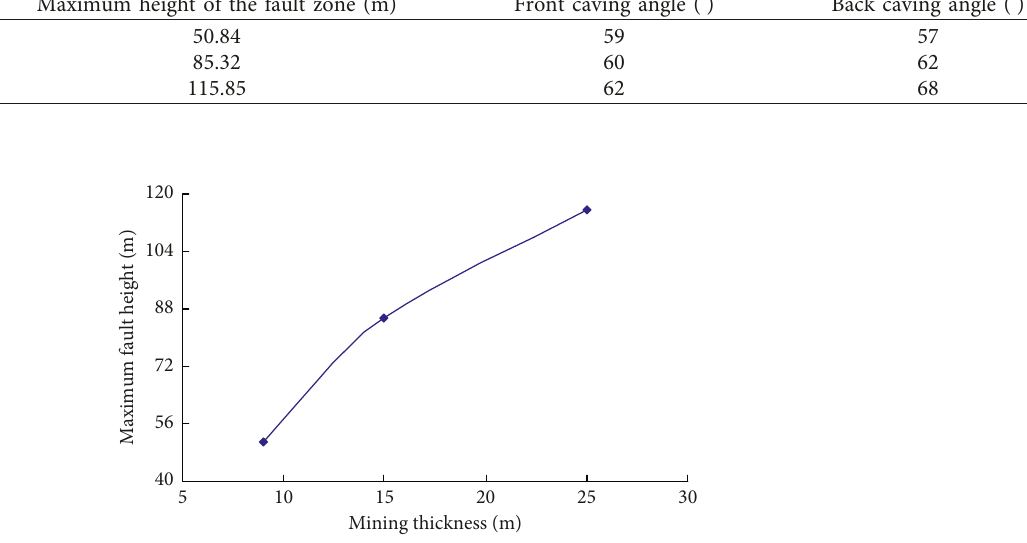
Figure 7: Relationship between the height of the maximum caving zones and the mining thickness.